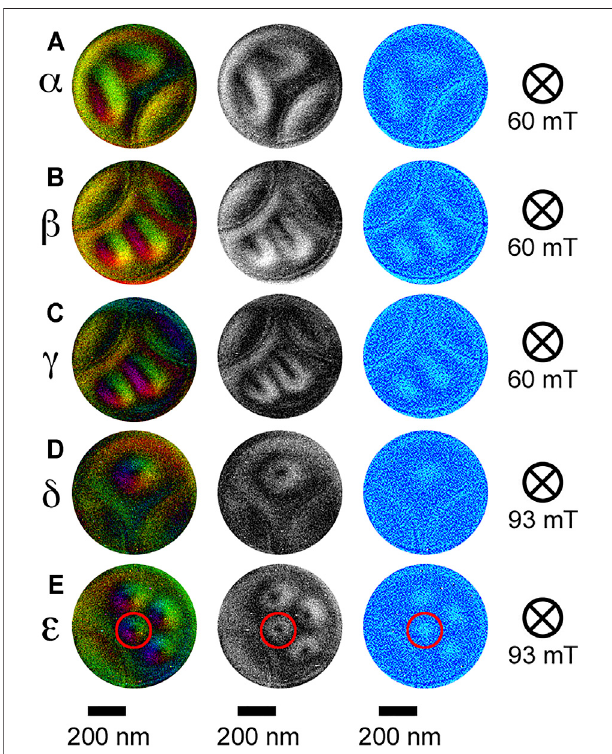
FIGURE 5 | Gallery of several deformed individual skyrmions arbitrarily extracted from Figure 4 . From left to right, in-plane magnetic induction as a color map, in-plane magnetic induction as intensity, and magnetic helicity image are shown. (A – E) The con fi ned areas as indicated by α - ε in the colormaps correspond totheareas indicatedin Figures4C,I .Acompressed circular skyrmion is indicated by a red circle in (E) .